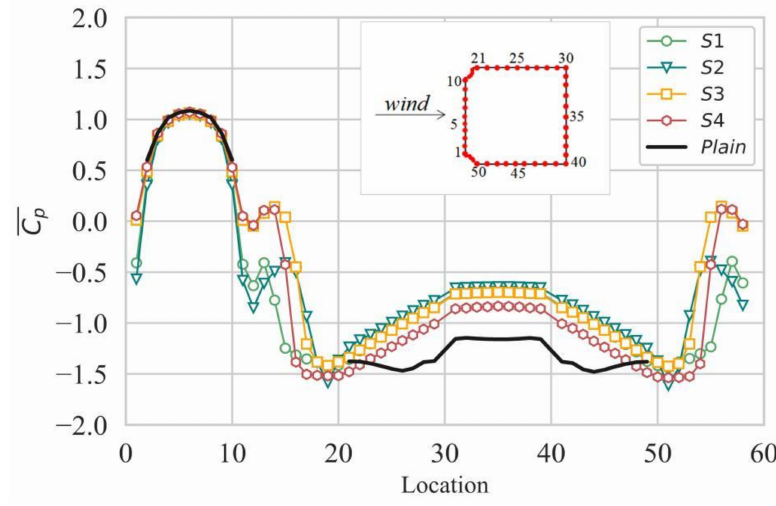
Figure 5. Mean pressure coefficients around the cylinder for the four stationary cases and plain cylinder.